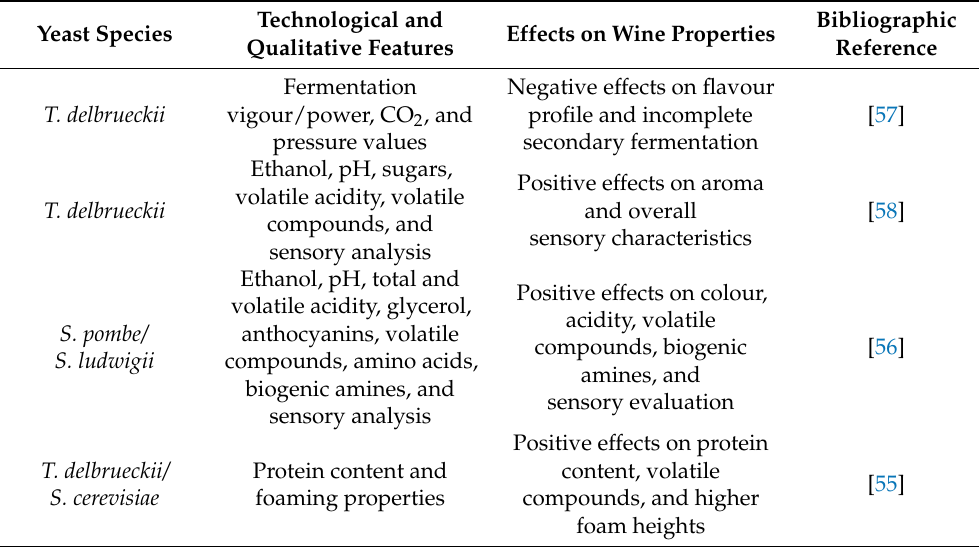
Table 4. Properties of the selection of non- Saccharomyces starter strains for the secondary fermentation of base